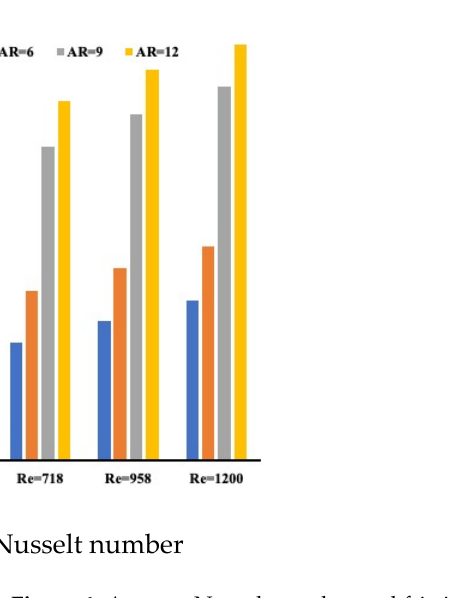
Figure 4. Average Nusselt number and friction factor for all cases (dp = 31 nm). However, this friction is noticeable for a low Reynolds number and decreases as the Reynolds number increases,